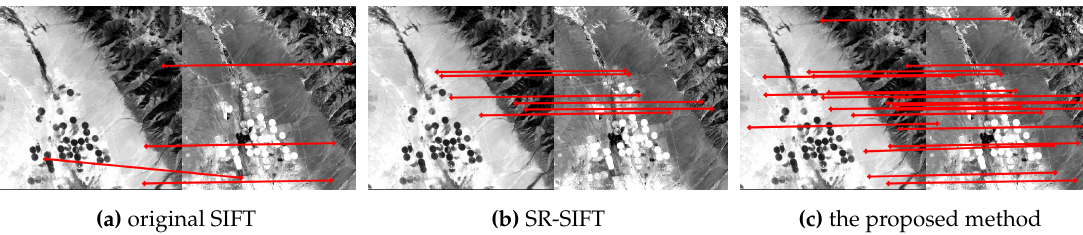
Figure 7. Matching results of the AVIRIS visible image tile (left) and the AVIRIS infrared image tile (right), using three different methods. ( a ) The result of original SIFT (four matches are found, including a wrong match); ( b ) the result of SR-SIFT (six correct matches are found); and ( c ) the result of the proposed method (20 correct matches are